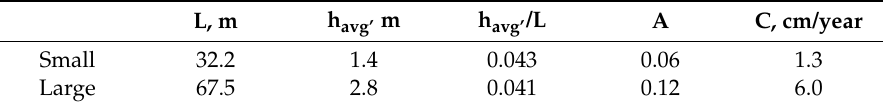
Table 3. Estimate of Migration Rates from Bedform Shape.